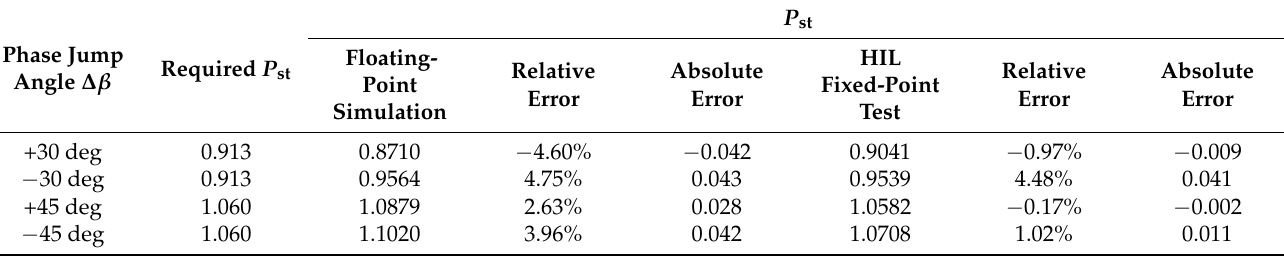
Table 7. Results of the phase jumps